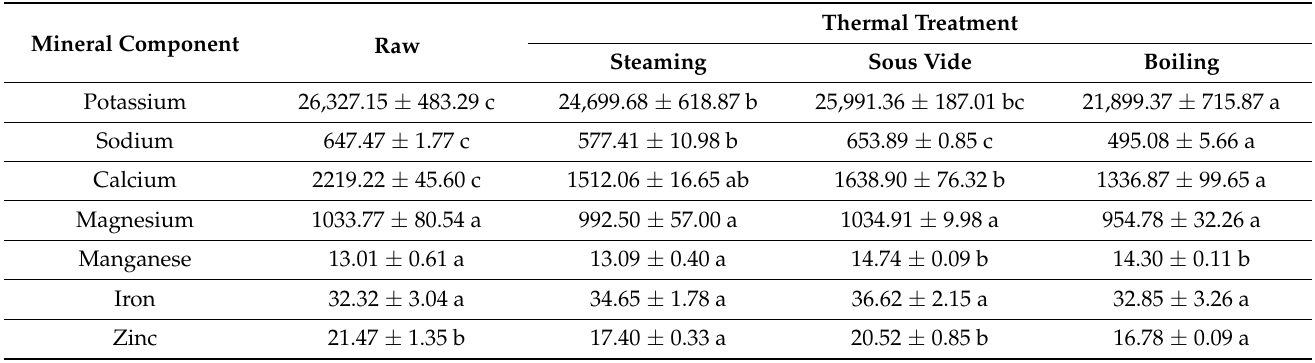
Table 4. Content of selected mineral components in raw and thermally treated Brussels sprouts (mg/kg